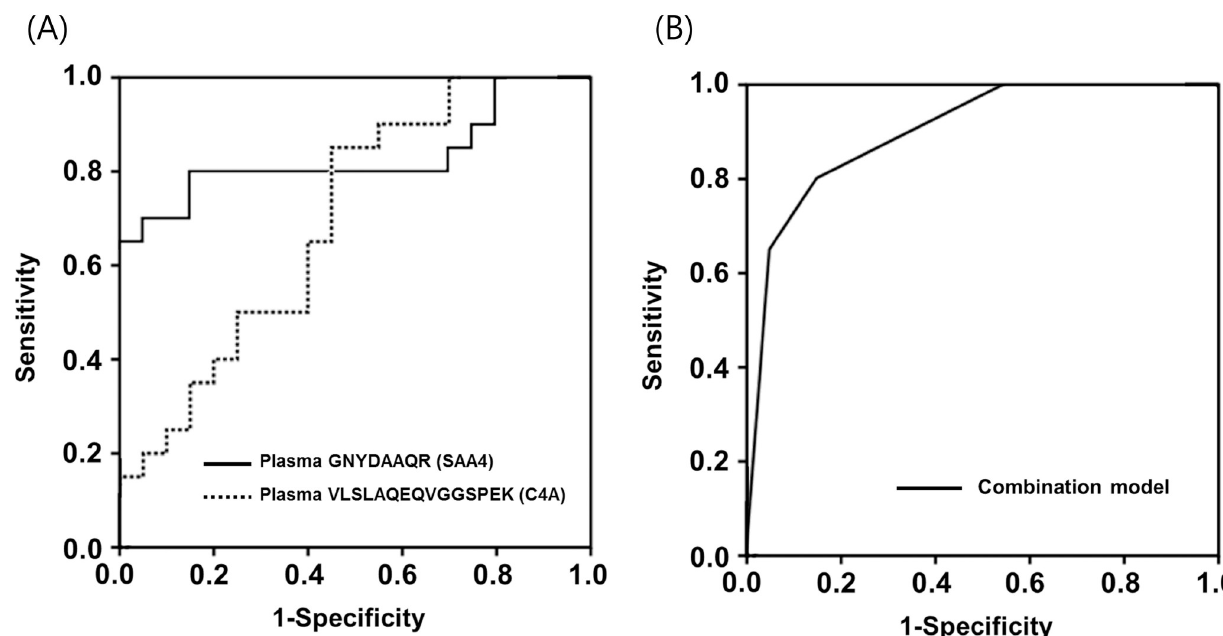
Fig 3. (A) ROC curves for three plasma GNYDAAQR (SAA4) and VLSLAQEQVGGSPEK (C4A) levels to predict HCA (area under the curve [AUC] ± standard error [SE] = 0.830 ± 0.071 and 0.695 ± 0.084, respectively). (B) ROC curve for the best combined predictive model [including plasma VLSLAQEQVGGSPEK (C4A) and GNYDAAQR (SAA4)] to predict HCA, with an AUC = 0.899 ( P < 0.05 for VLSLAQEQVGGSPEK vs. the combined predictive model, and P = 0.19 for GNYDAAQR vs. the combined predictive model). C4A, complement C4-A; HCA, histologic chorioamnionitis; ROC, receiver operating characteristic; SAA4; serum amyloid